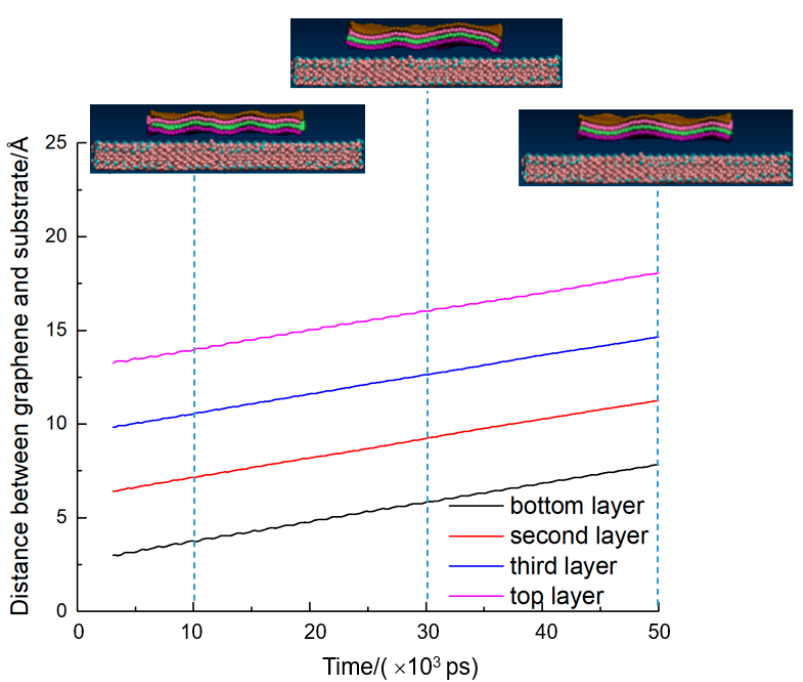
Figure 4. Exfoliation process in four-layer graphene system at the vertical upward velocity 0.9 Å/ps (the first critical velocity). The dotted blue line shows the trajectory at different points in time.